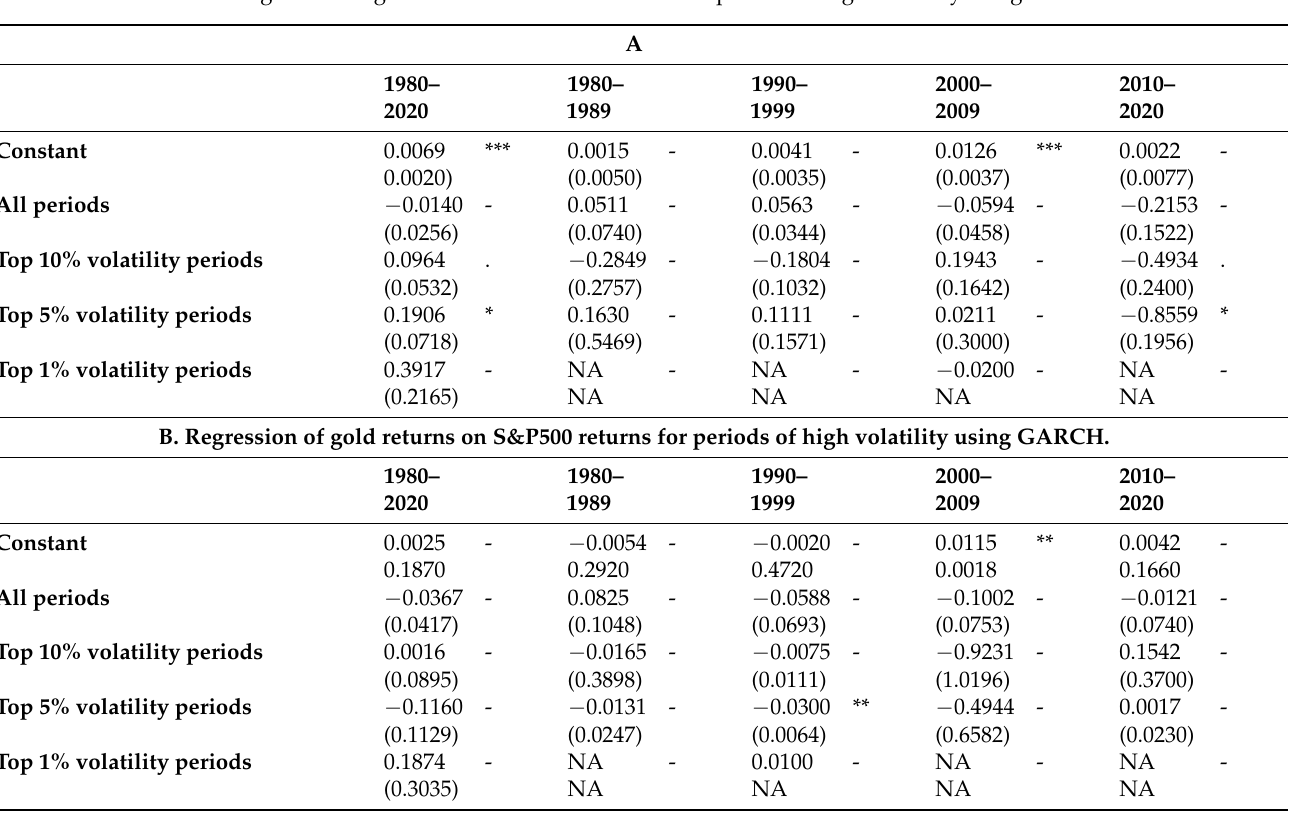
Table 5. Regression of gold returns on Sensex returns for periods of high volatility using